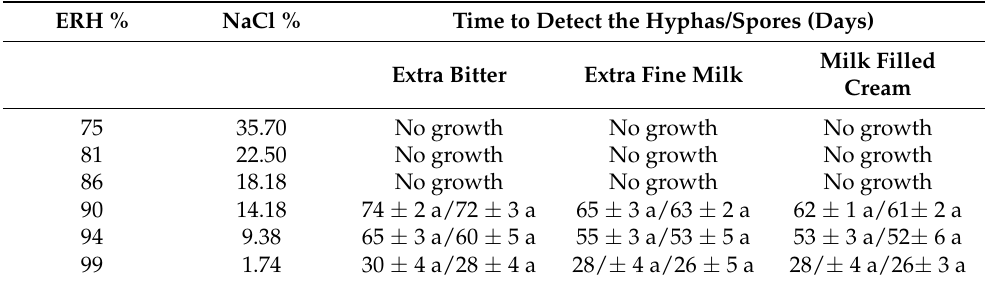
Milk Filled Cream